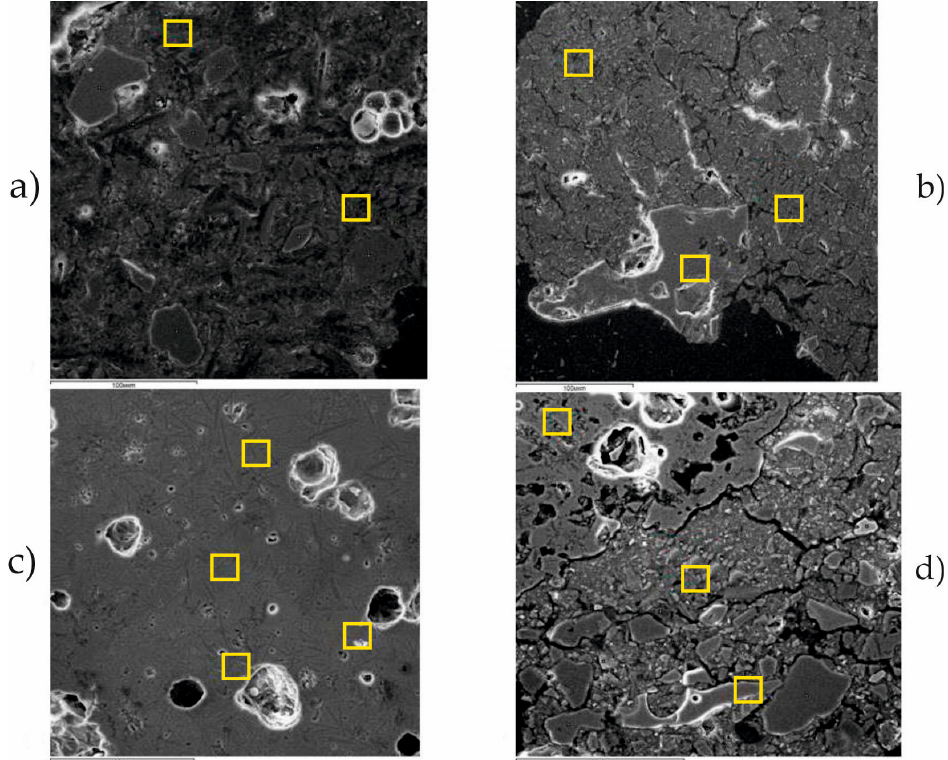
Figure 7. Scanning electron microphotographs of the basalts and pisolites of the andesitic and mafic composition on the polished thin sections from the core unit of 323–340 cm: ( a ) Irregularly elongated non-rounded black grain composed of mainly andesitic (SiO 2 content of 52.39–58.97%) and sometimes persilicic (SiO 2 content of 64.94%) dust in the sample of 328–330 cm. Inclusions are more massive mafic shards, quartz, and microfossil fragments. ( b ) Semi-rounded black shard composed of andesitic ash dust with a mean SiO 2 content of 57.5% in the sample of 328–330 cm. Inclusions are occasionally more massive basalt shards with a SiO 2 content of 49.22%. ( c ) Microlithic basalt glass with a mean SiO 2 content of 50.31% in the sample of 328–330 cm. Microlites are intermediate / mafic plagioclase. ( d ) Semi-rounded black shard composed of andesitic ash dust with a SiO 2 content of 54.83% in the sample of 338–340 cm. Inclusions are occasionally larger basalt fragments with a mean SiO 2 content of 50.52% and some possible Fe oxides. Yellow-outlined rectangles show points of